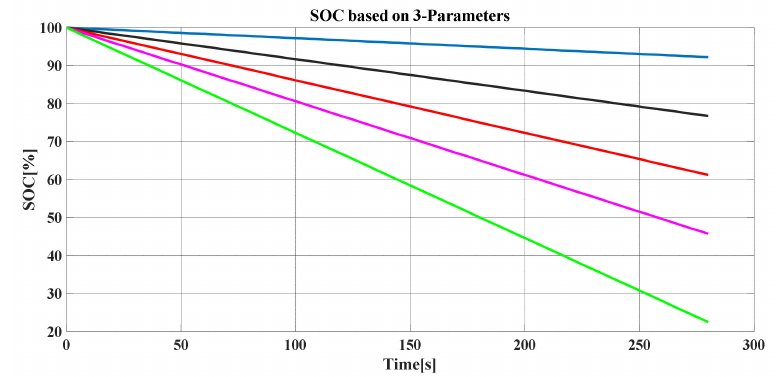
Figure 20. The di ff erent SOCs of the battery based on the TPM.